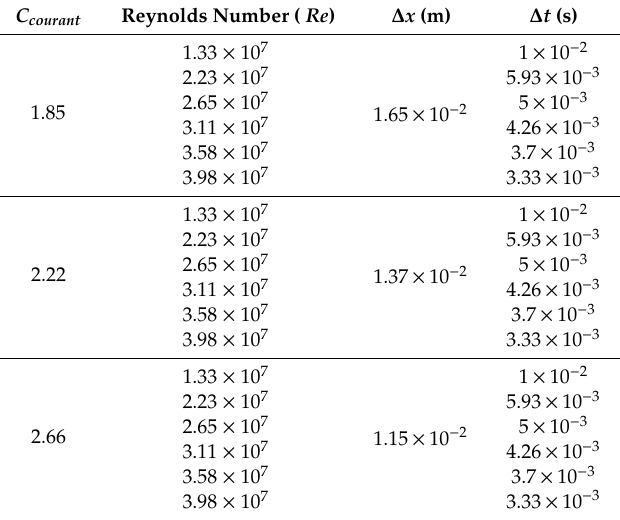
Table 4. The respective Courant–Friedrichs–Lewy conditions for GCI analysis.